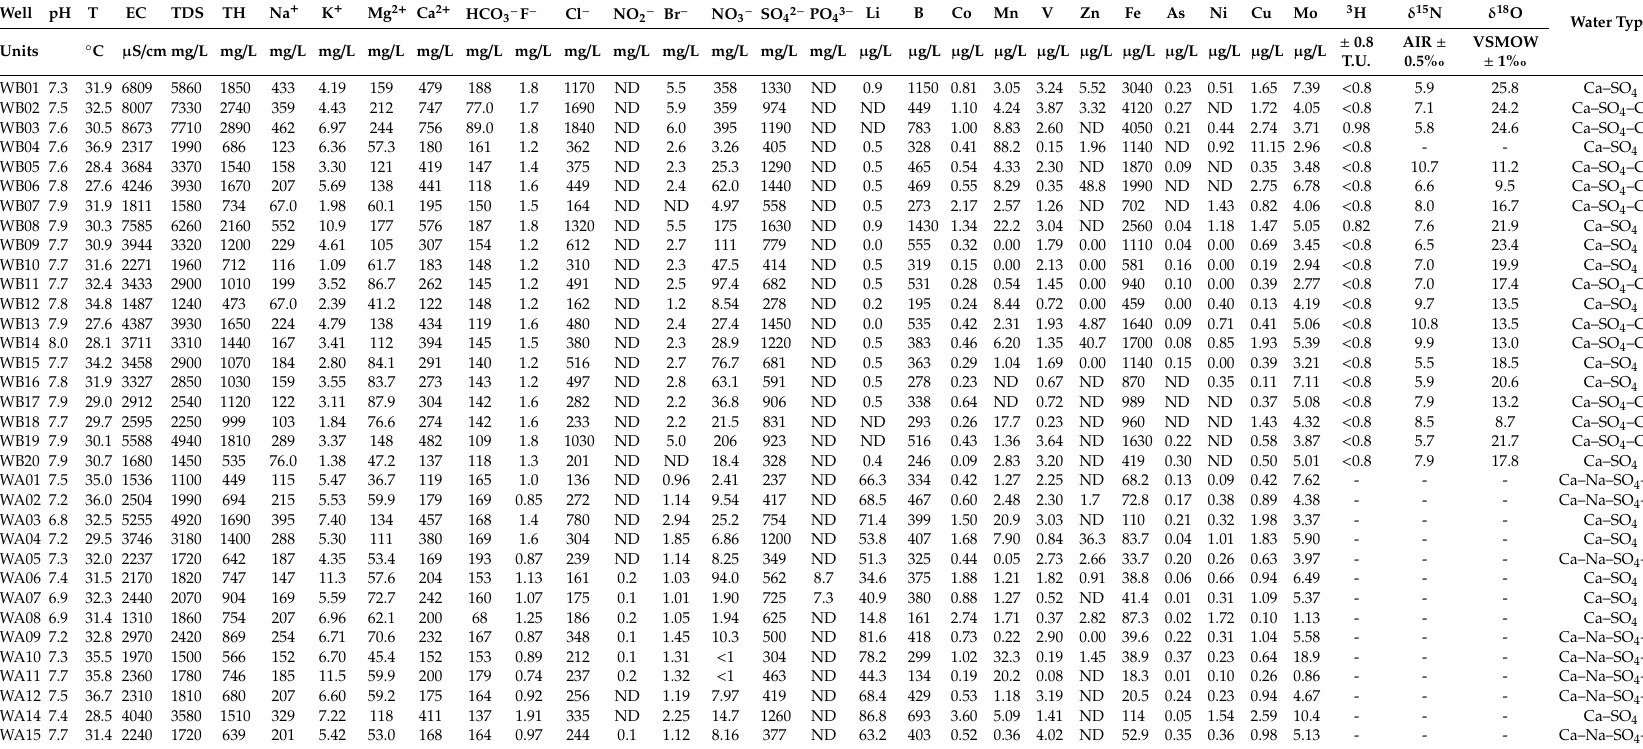
Table 2. Hydrochemical parameters, stable isotope ratios of nitrates (15N–NO3 and 18O–NO3), and tritium measurements for selected groundwater samples from the Wasia aquifer in the study